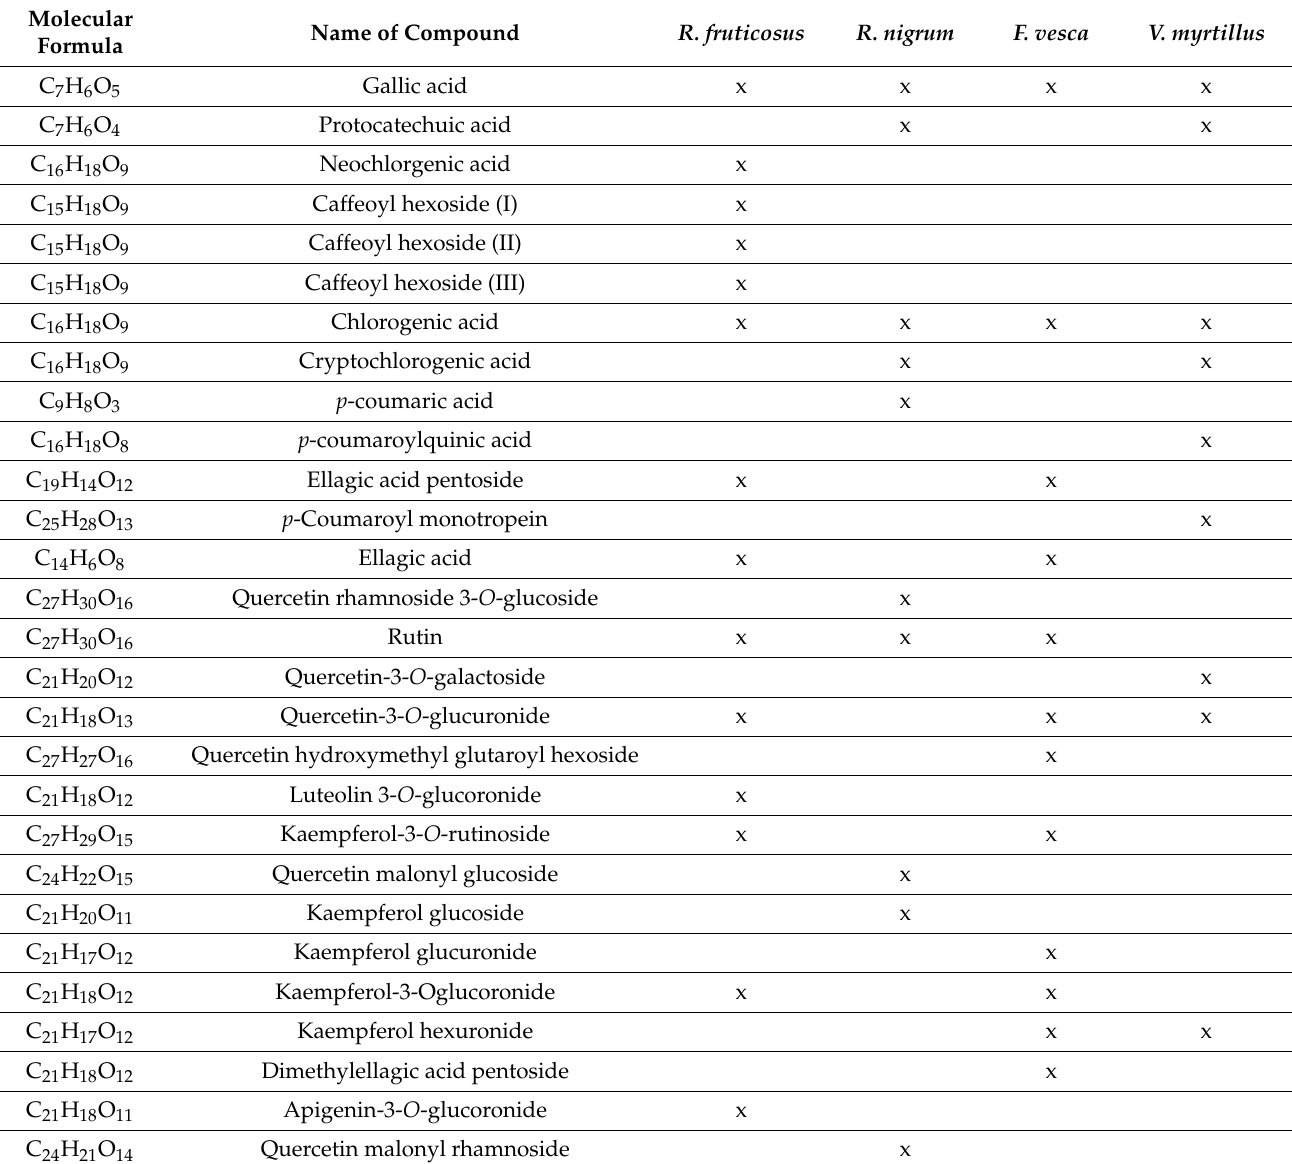
Table 1. Bioactive compounds detected using UHPLC/DAD/ESI–MS in R. fruticosus L., R. nigrum L., F. vesca L., V. myrtillus L. An x indicates the occurrence of the detected compounds in the tested